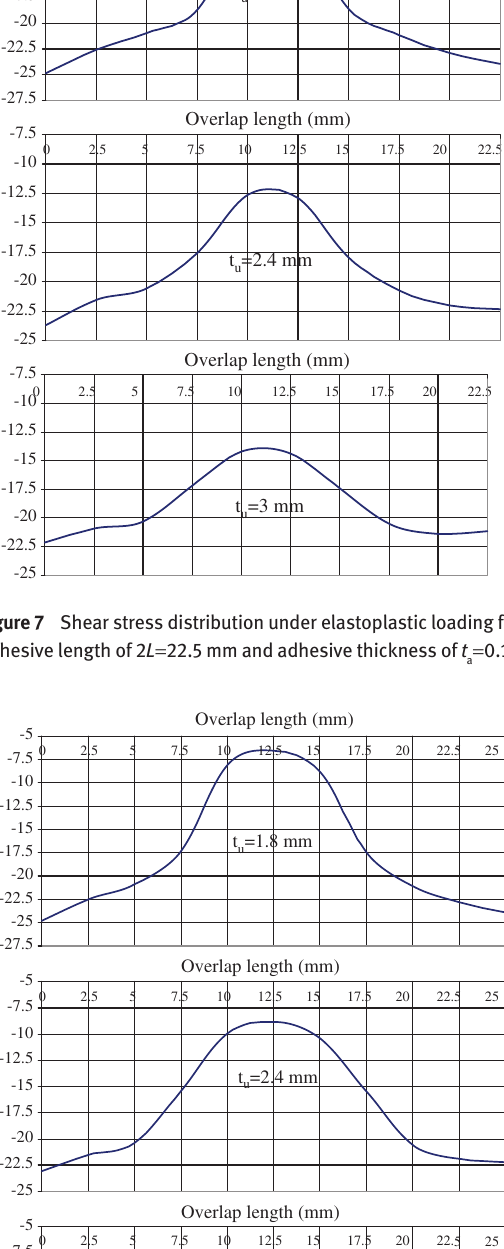
Figure 8 Shear stress distribution under elastoplastic loading for adhesive length of 2 L = 25 mm and adhesive thickness of t